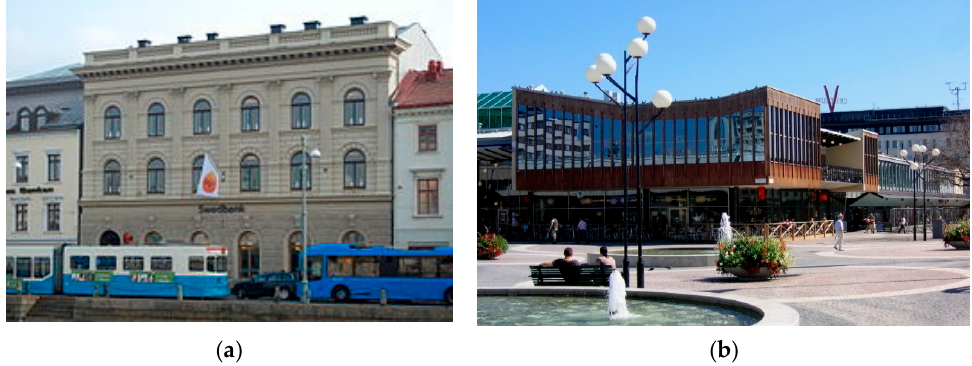
Figure 3. ( a) House built for a bank in the 1890s, with a solid, almost repelling front. ( b) Community center from 1950s, with public space, shops and bank services (Photos PDM).